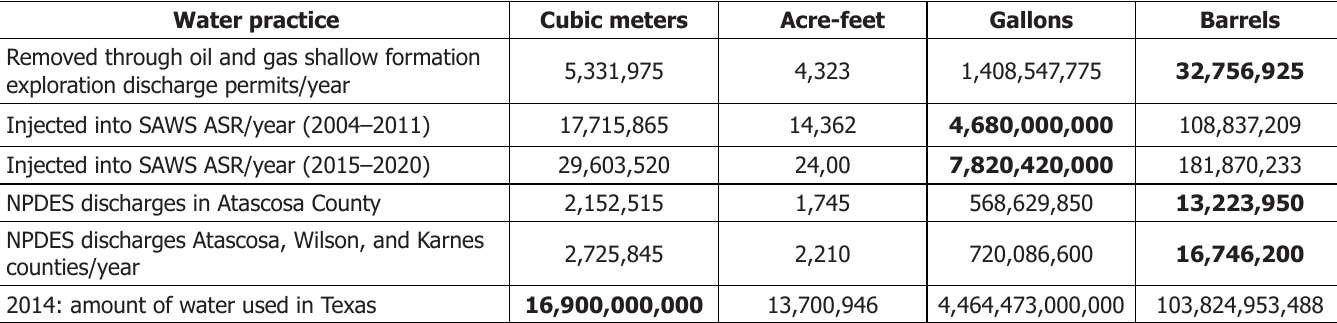
Table 1. Water volumes. The numbers indicated in bold font are numbers taken from researched data. All other numbers are converted through standard conversion